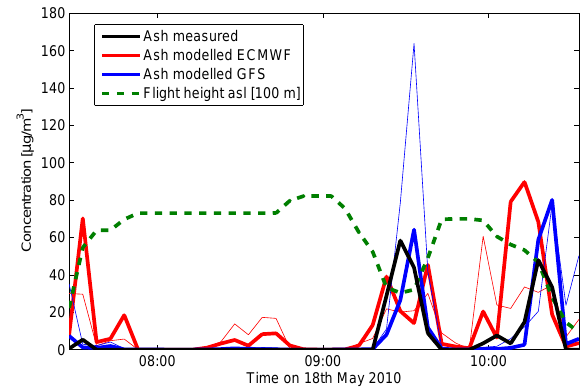
Fig. 8. Measured (black line) and modeled (red lines, ECMWF; blue lines, GFS) five-minute average ash mass concentrations along the Falcon flight path of the first available research flight over Ger- many on 19 April 2010. A priori model values are shown with thin lines, a posteriori model values with thick lines. Flight height is shown in green (in units of 100m). The mass concentration peak in the aircraft data at around 15:30 may include a contribution of pol- luted boundary aerosol which cannot be be separated from volcanic ash.